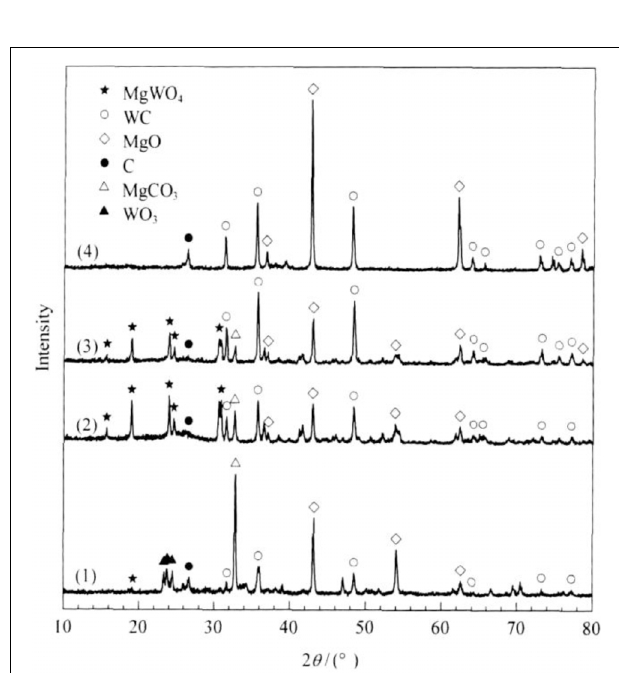
FIGURE 13 | XRD patterns of WC powders synthesized at different temperatures for 15 h: (1) 500 ◦ C; (2) 550 ◦ C; (3) 600 ◦ C; (4) 650 ◦ C (Zeng et al., 2008) [Figure 1 of Zeng et al. (2008), Copyright Science